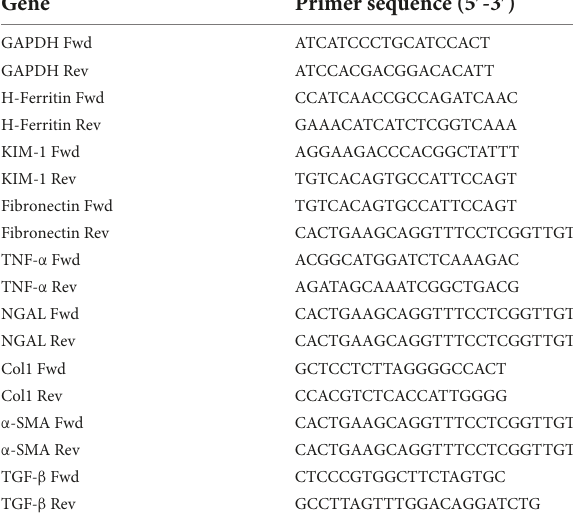
TABLE 1 Primers for real-time PCR